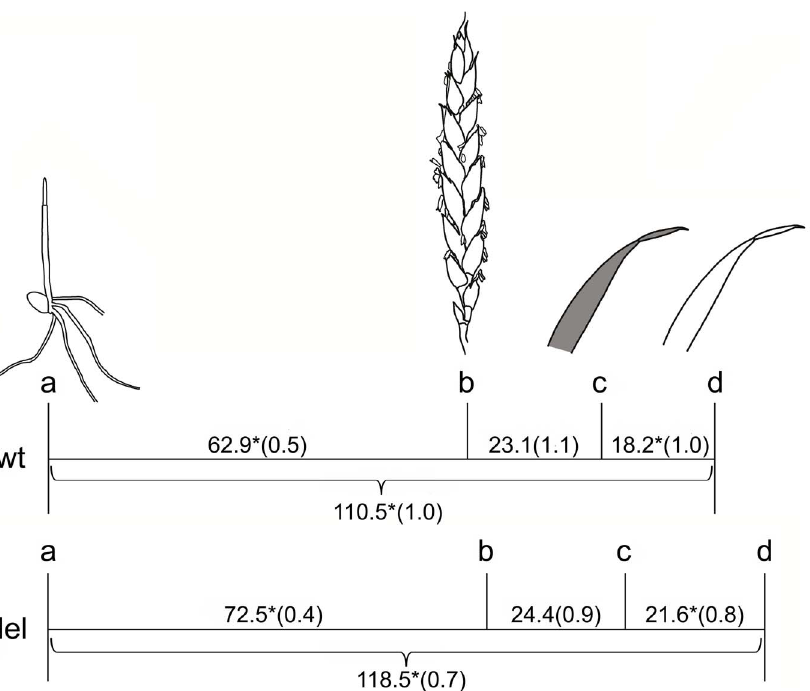
Figure 2. Timeline of development of varieties with the wt allele and varieties with the deletion. The scale is mean number of days (SE in brackets). Time spans that are significantly different between the allele types are indicated with * on both groups of varieties (p , 0.001).